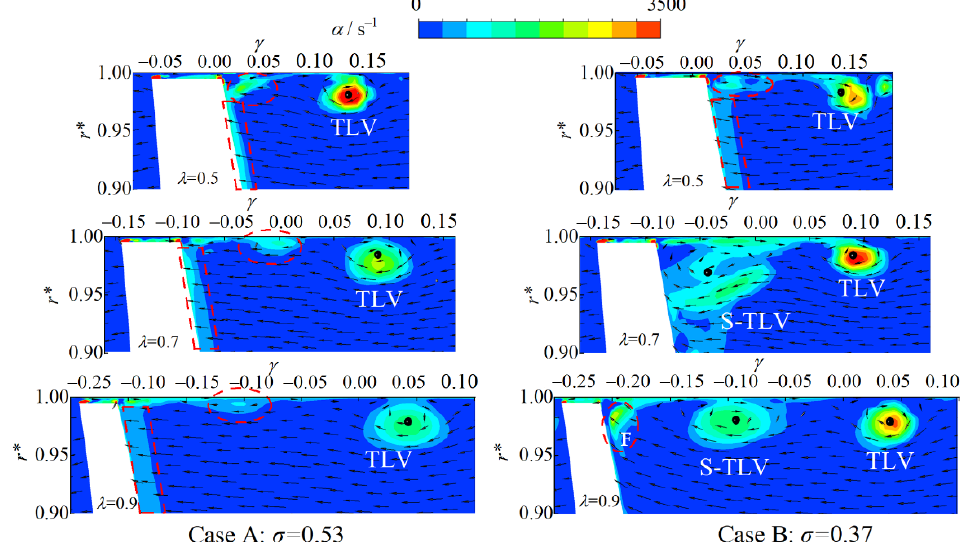
Figure 16. Distributions of vortex intensity on three planes.